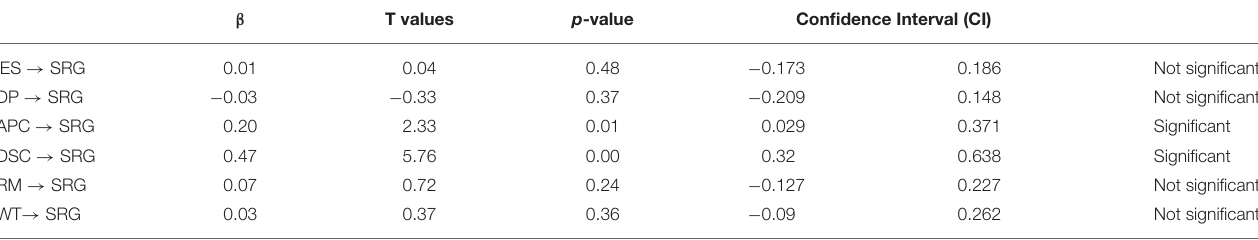
TABLE 3 | Direct effect results.